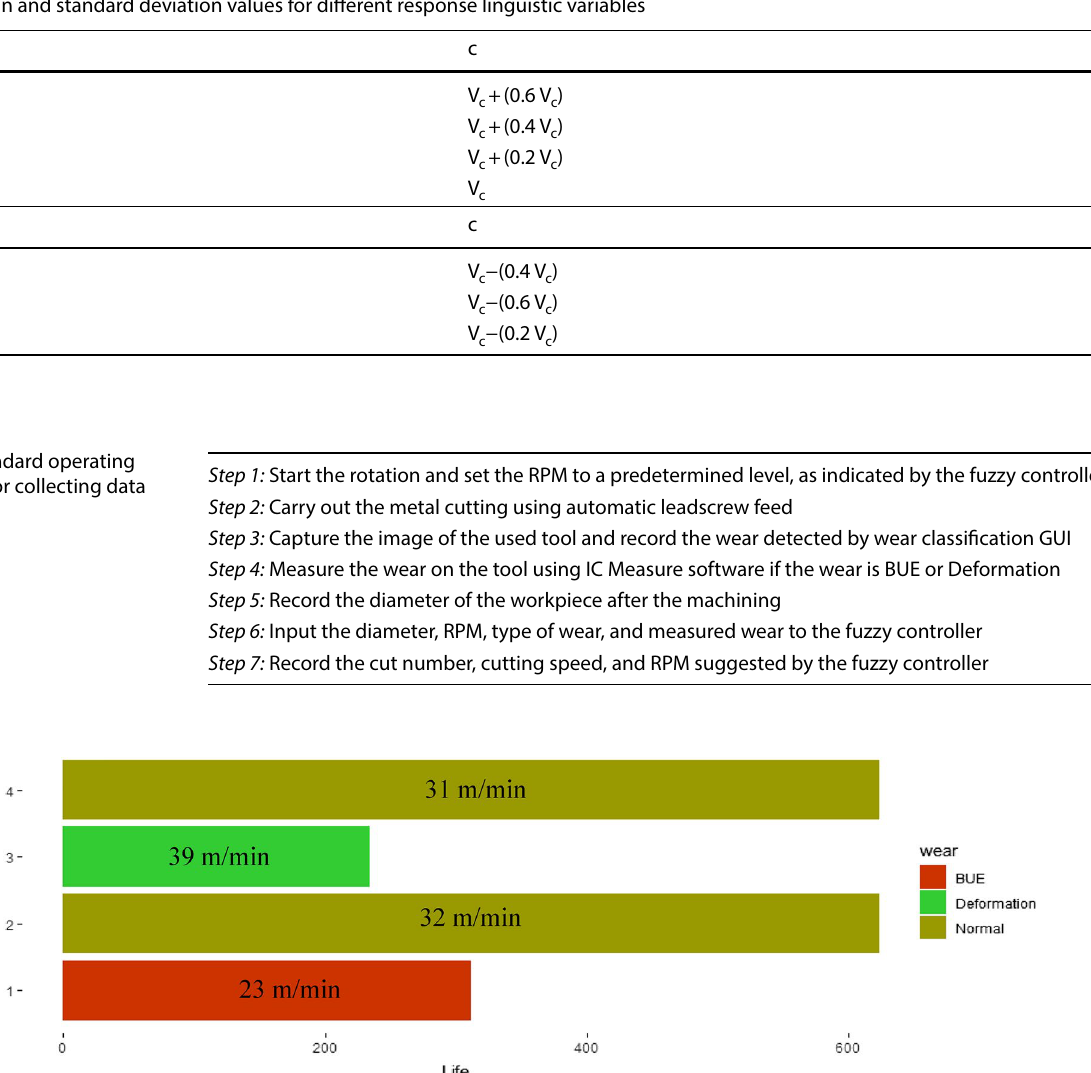
Fig. 10 Consolidated results from the experimental data presented in Appendix